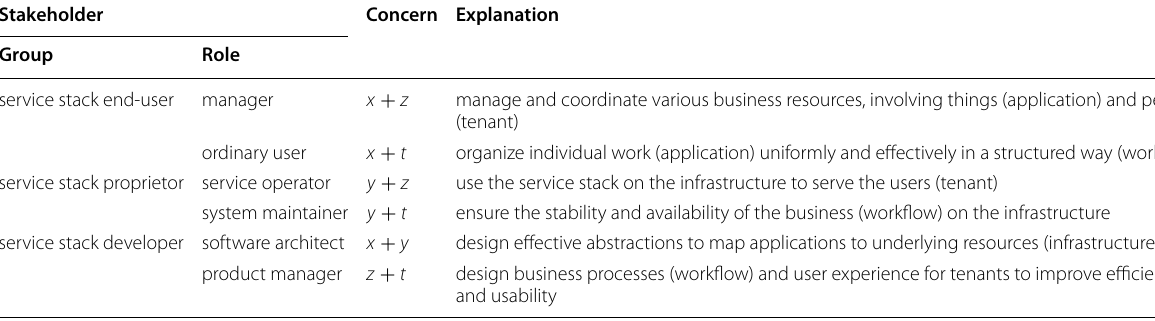
Table 2 The perspective view of the cloud-native light-cone model